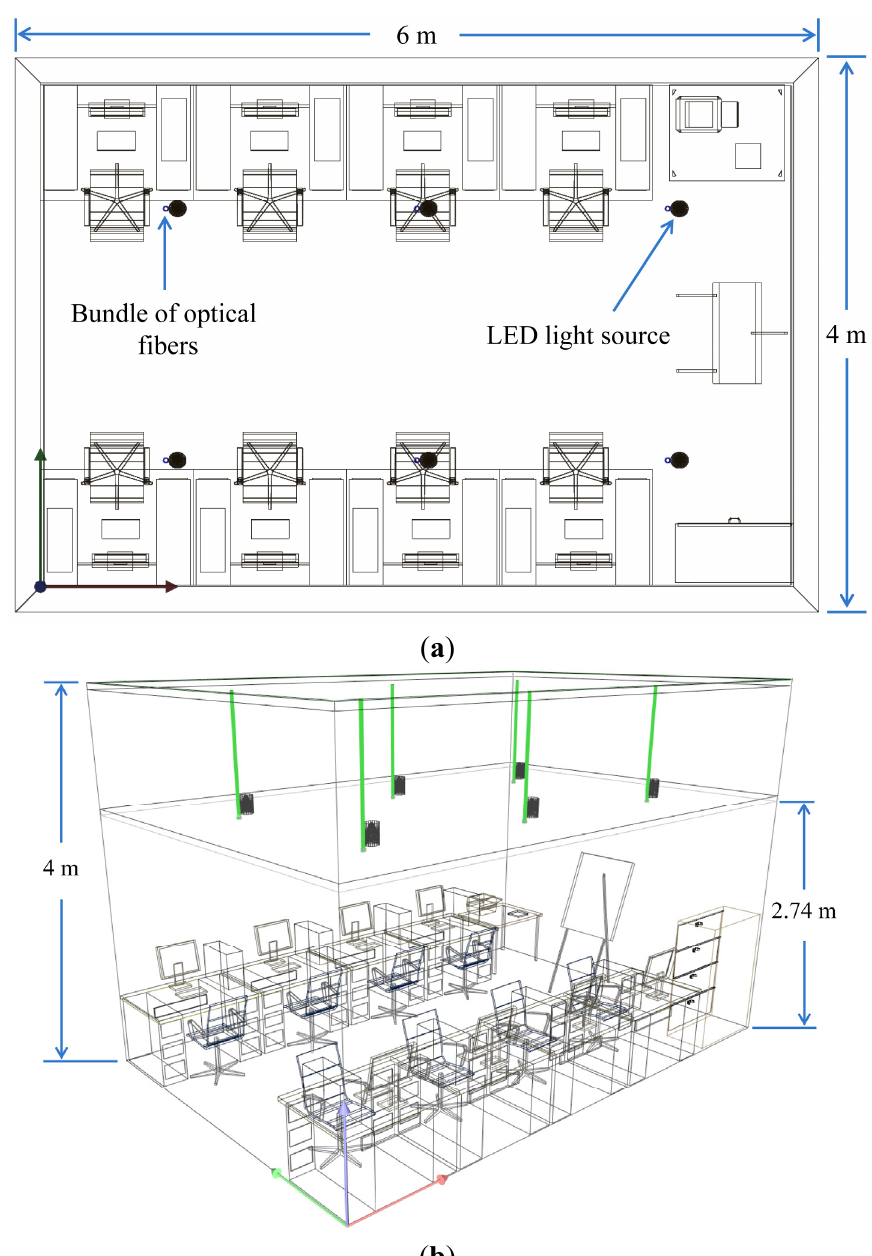
Figure 6. ( a ) Floor plan of the office and ( b ) Section view of the